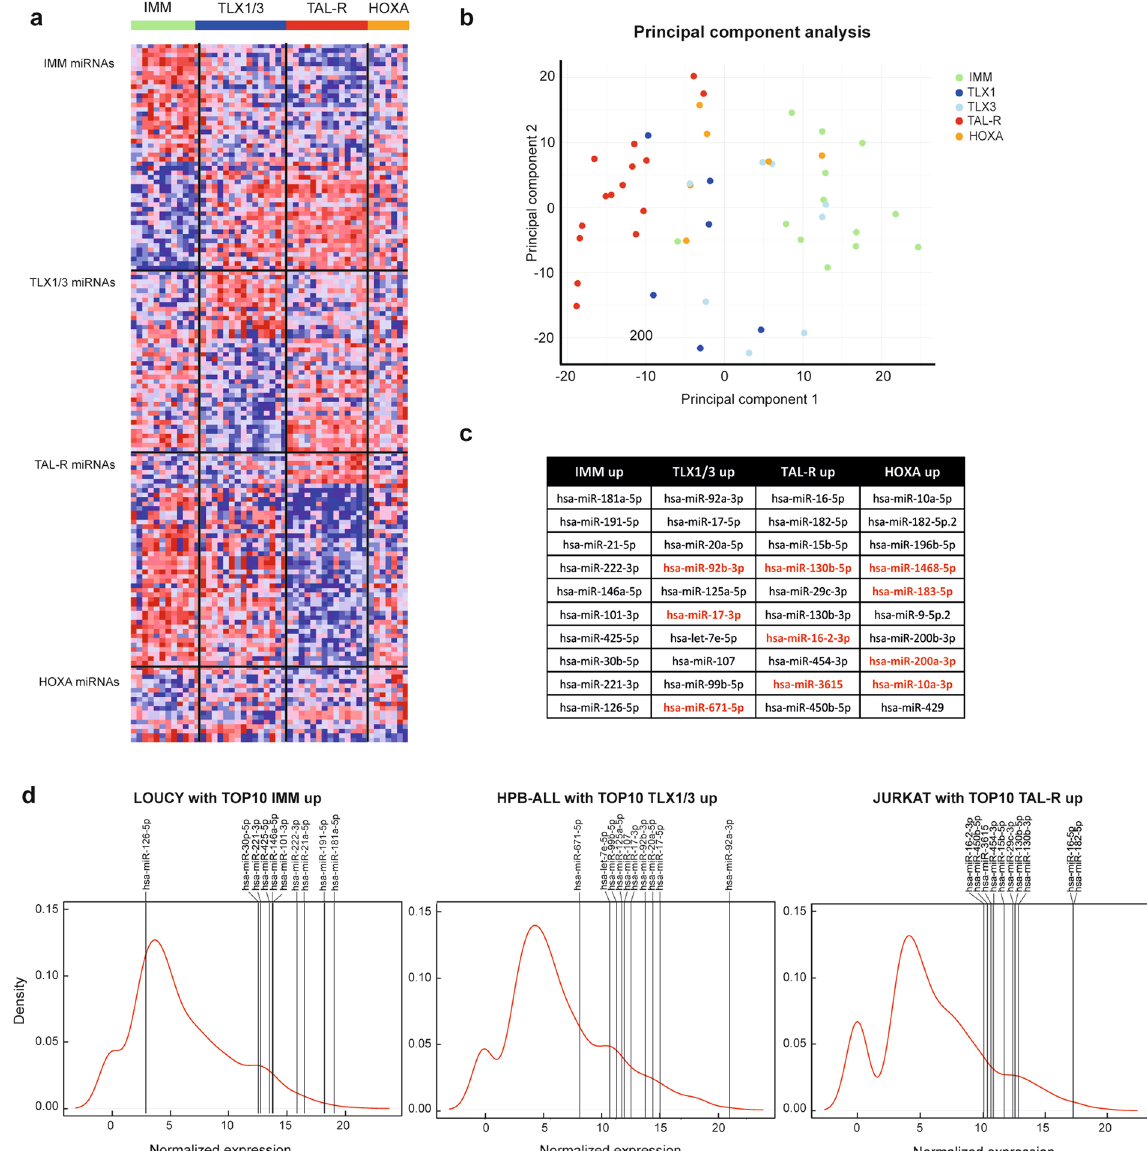
Figure 2. Small RNA-sequencing of primary T-ALL samples reveals a subtype specific expression pattern of miRNAs. ( a ) Heatmap representing the top 50 most significantly up- or downregulated miRNAs per subgroup in comparison to the other subgroups (adjusted p-value < 0.05). (b ) PCA-plot showing the distribution of the patient samples. The different colors denote patient samples from a different subgroup. (c ) Table representing the selection of 10 miRNAs per subgroup. These were the highest expressed miRNAs that were significantly upregulated in that subgroup compared to the other subgroups. MiRNAs denoted in red were not detected by a previously used qRT-PCR platform. ( d ) Density plots representing the distribution of the miRNA expression in the LOUCY, HPB-ALL and JURKAT cell line. Vertical bars show the expression level of the top 10 miRNAs selected for the subgroup these cell lines represent. LOUCY represents the immature T-ALL subgroup, HPB- ALL the TLX1/3 subgroup and JURKAT the TAL-R